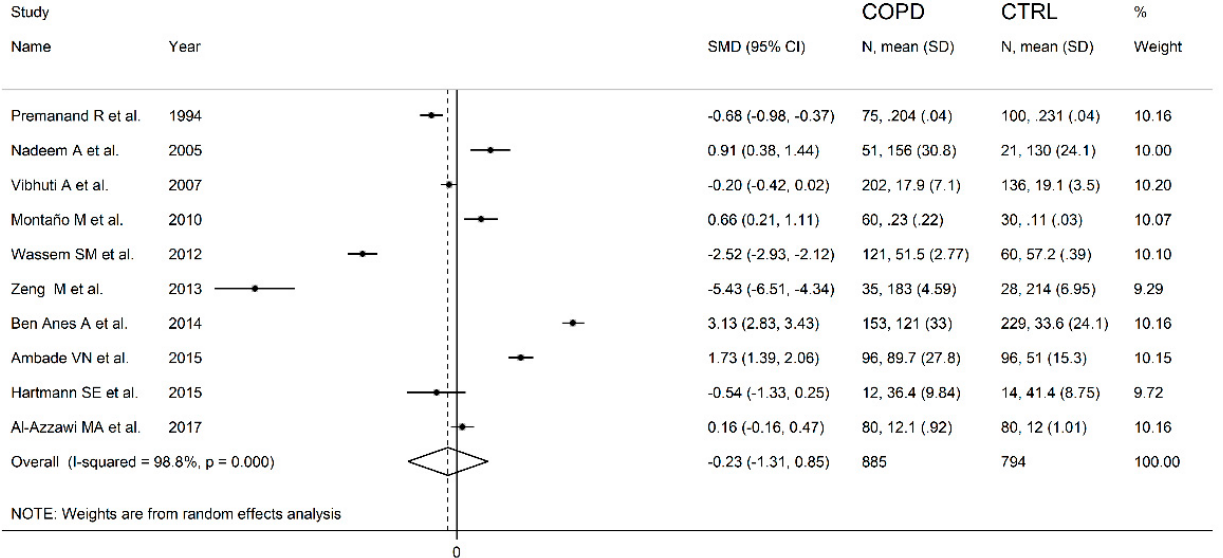
Figure 7. Forest plot of studies examining the serum/plasma GPx values of COPD and non-COPD.